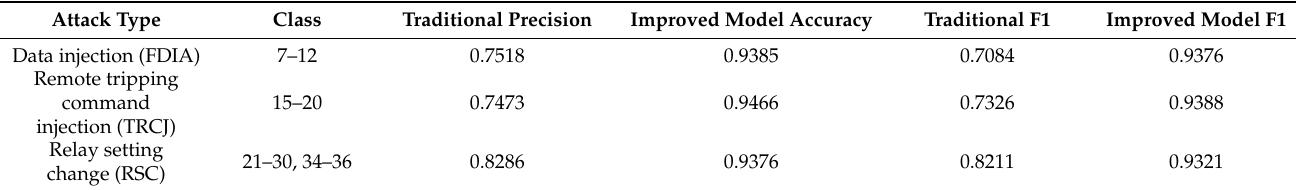
Table 3. Large sample network attack detection